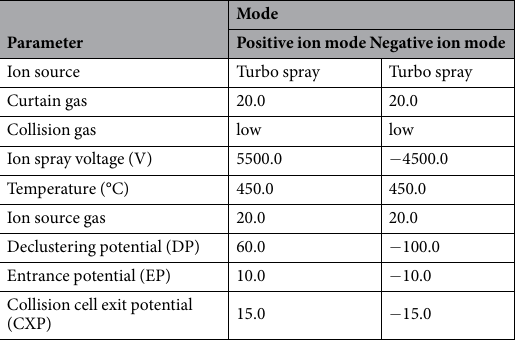
Table 2. Parameters of the MRM